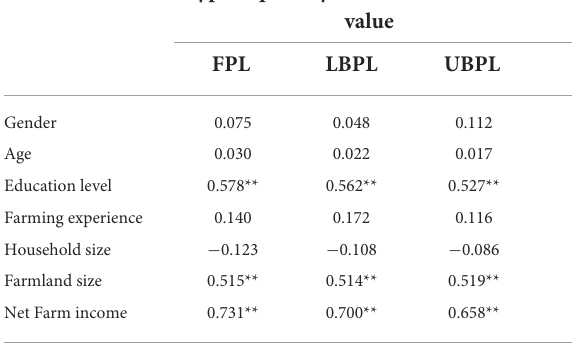
TABLE 6 Pairwise comparisons of the impact of the Ilima-Letsema programme on FPL, LBPL and UBPL ( n = 196). Sample 1–